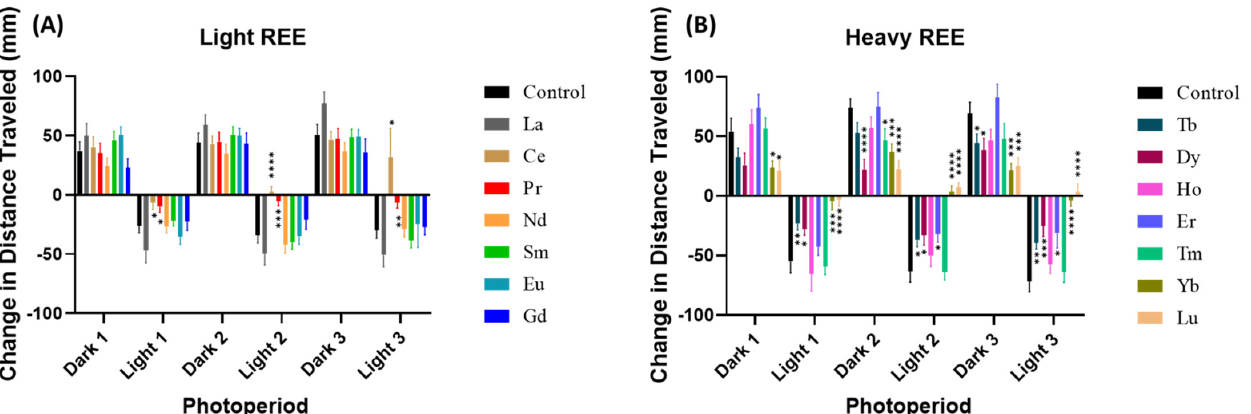
Figure 3. The photo motor response (PMR) of zebrafish after 96 h exposure to 1 ppm of ( A ) light REE and ( B ) heavy REE. The data are expressed as mean ± SEM and statistical differences were analyzed by two-way ANOVA followed with Fisher’s LSD test (* p < 0.05, ** p < 0.01, *** p < 0.001, **** p < 0.0001). Table 1. Lists are LC 50 , Lanthanide’s atomic number, an index for heavy rare earth elements, Lan- thanide’s charge, and aromatic C avg charge.